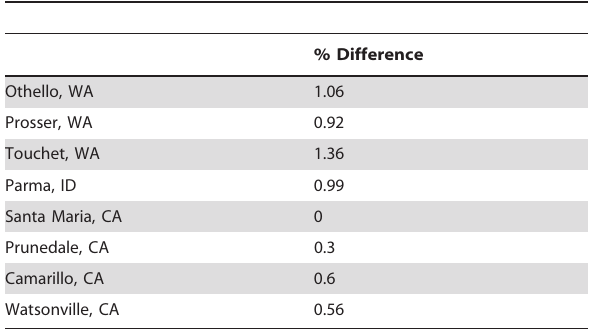
Table 9. Pairwise distances within populations of L. hesperus